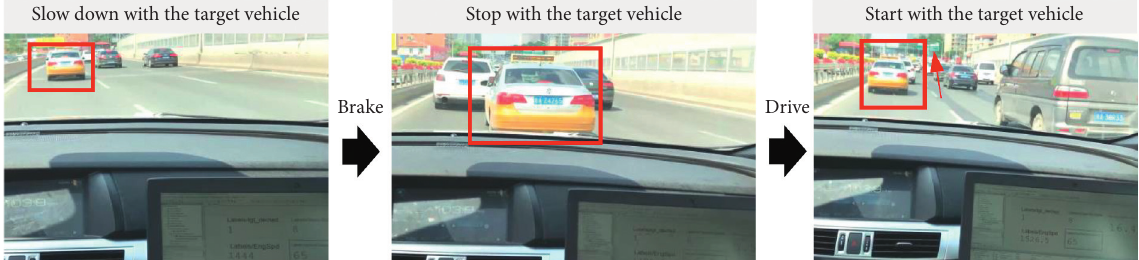
Figure 13: The real vehicle automatic stop-and-go task under the urban overpass driving condition.